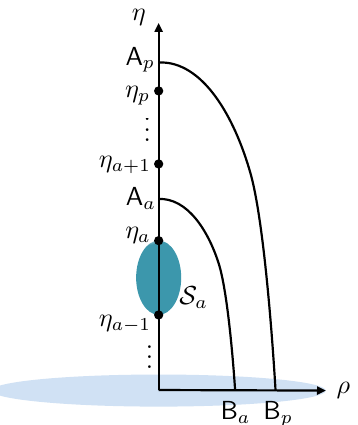
a B a form part of the 4-cycle C a . The bubble B a